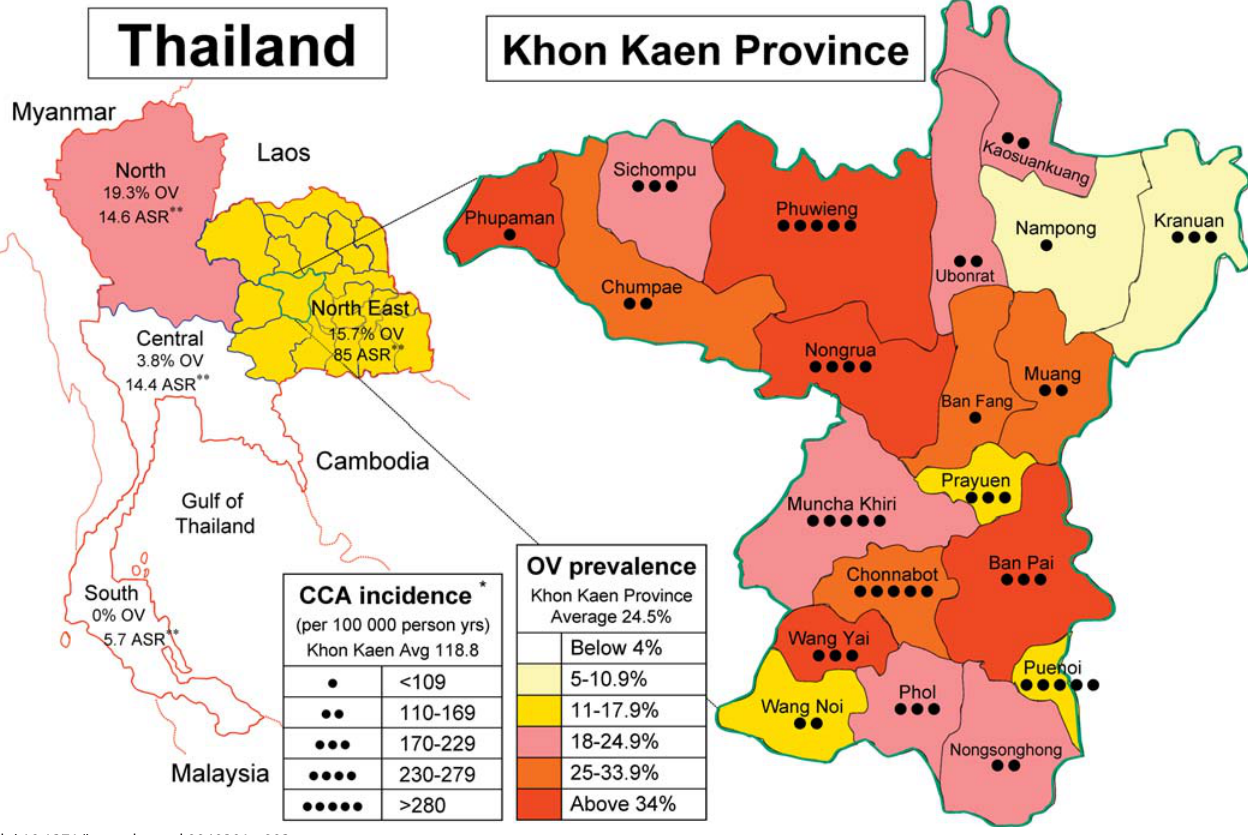
Figure 3. Incidence of CCA and O. viverrini in Thailand from 1990–2001 Increasing intensity of red represents increasing prevalence of O. viverrini , while increasing number of dots represents increasing cancer rates. In general, higher O. viverrini prevalence correlates with a higher CCA burden, although sporadic anthelmintic therapy has infl uenced this relationship. It should be noted that even one spot represents signifi cant cancer rates anywhere else in the world. *Truncated age-standardised incidence from 35–64 years. **Age-standardised incidence of CCA throughout registered regions. Adapted from